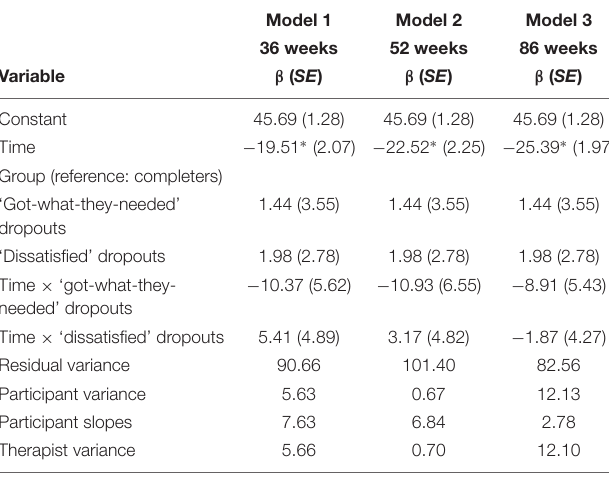
TABLE 4 | Mixed effect models predicting MFQ scores from Time and Therapy Ending Type, with completers as the reference